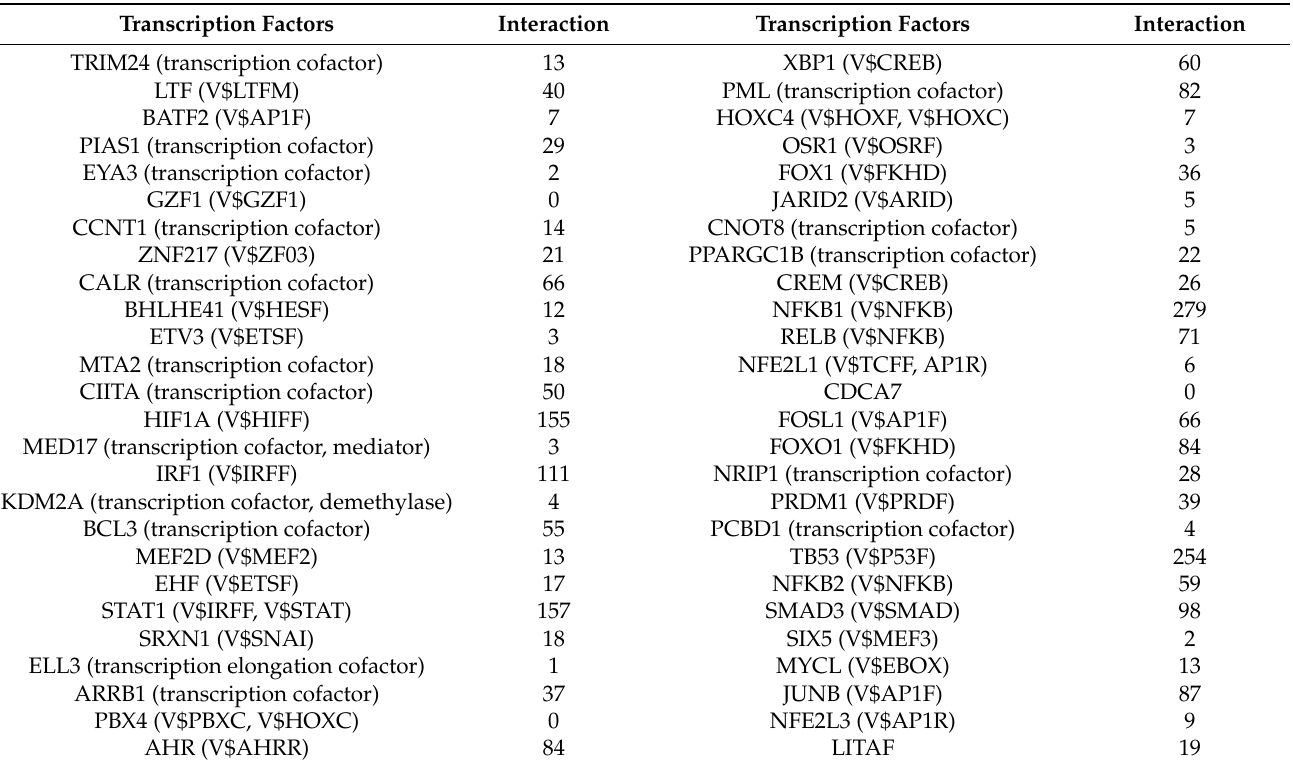
Table 5. List of TFs and their interaction with genes using the Genomatics